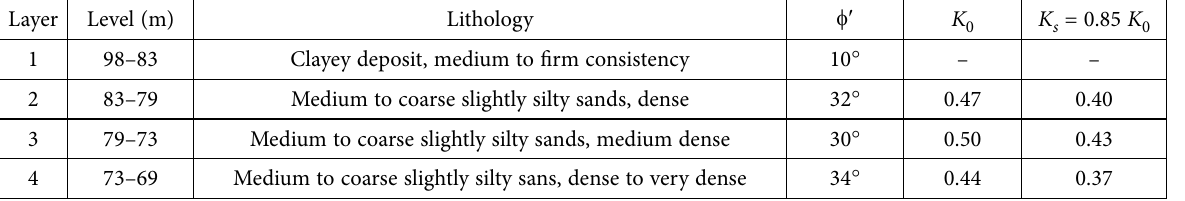
Table 3. The coefficient of horizontal soil stress ( K Layer